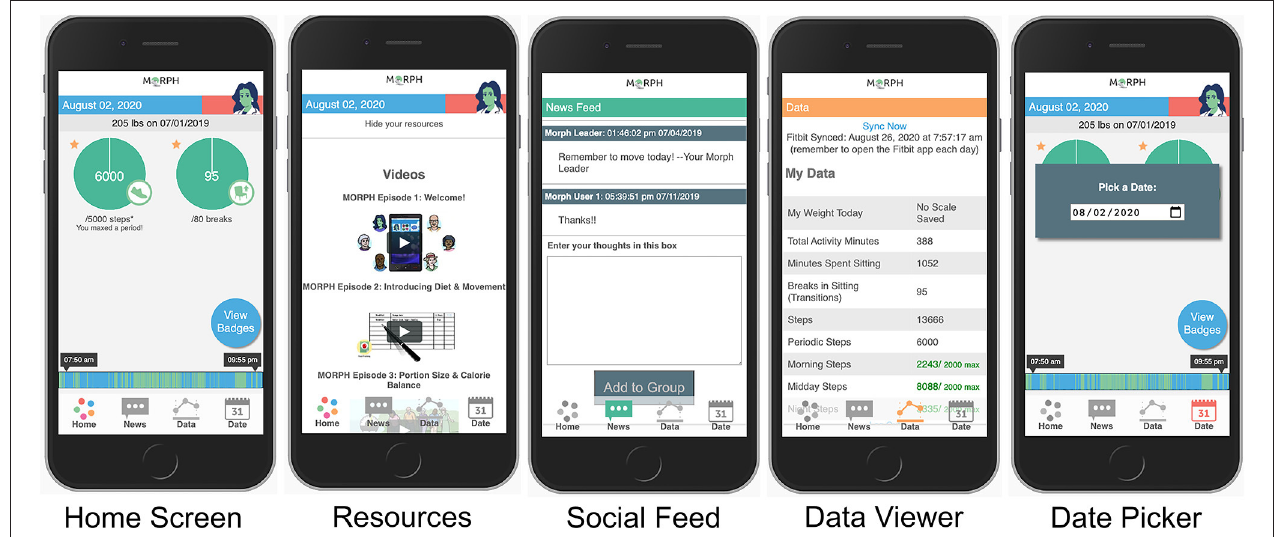
FIGURE 1 | Example MORPH screens. The first depicts the landing page, with quick-view stepping and break information, a daily weigh-in display, access to mastery badges, and the activity timeline bar wherein green represents movement and blue represents non-movement. The second depicts the in-app social feed. The third depicts the daily data summary page, which displays data from the smart scale and the wearable activity monitor. The final displays the resources page, where participants can view weekly videos and listen to weekly podcasts.